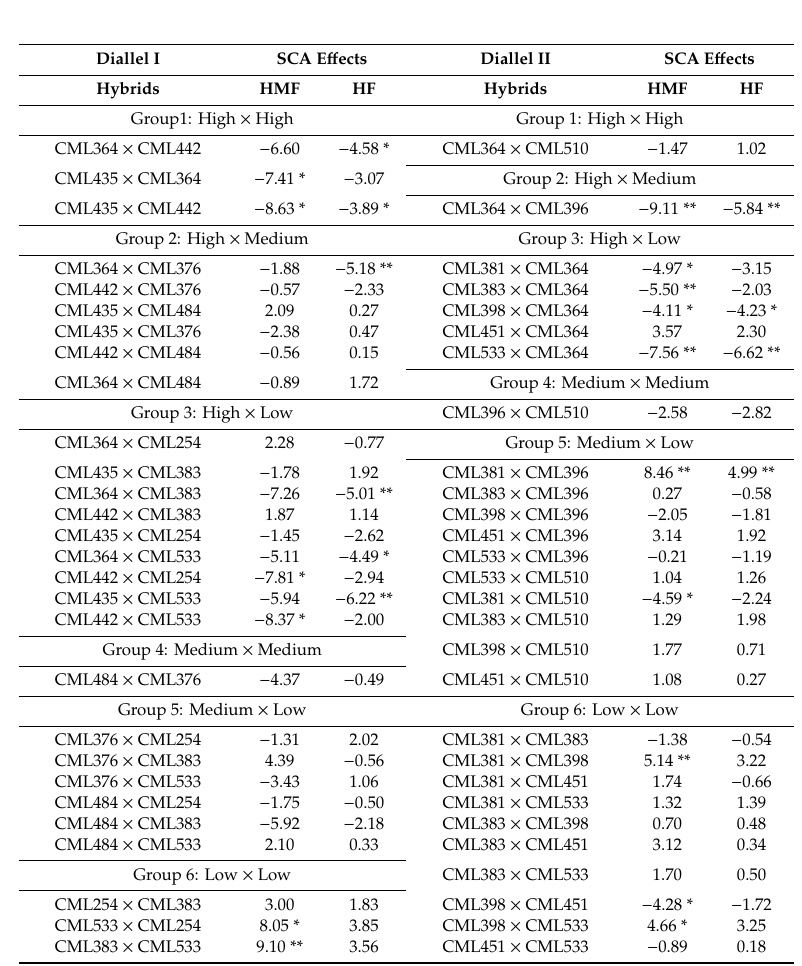
Figure 3. Prediction of hybrid performance for HMF (red dots) and HF (blue dots) based on means of the parental value and GCA effects in two diallel experiments. Table 6. Estimates of specific combining ability (SCA) e ff ects across two environments in Diallel I and Diallel